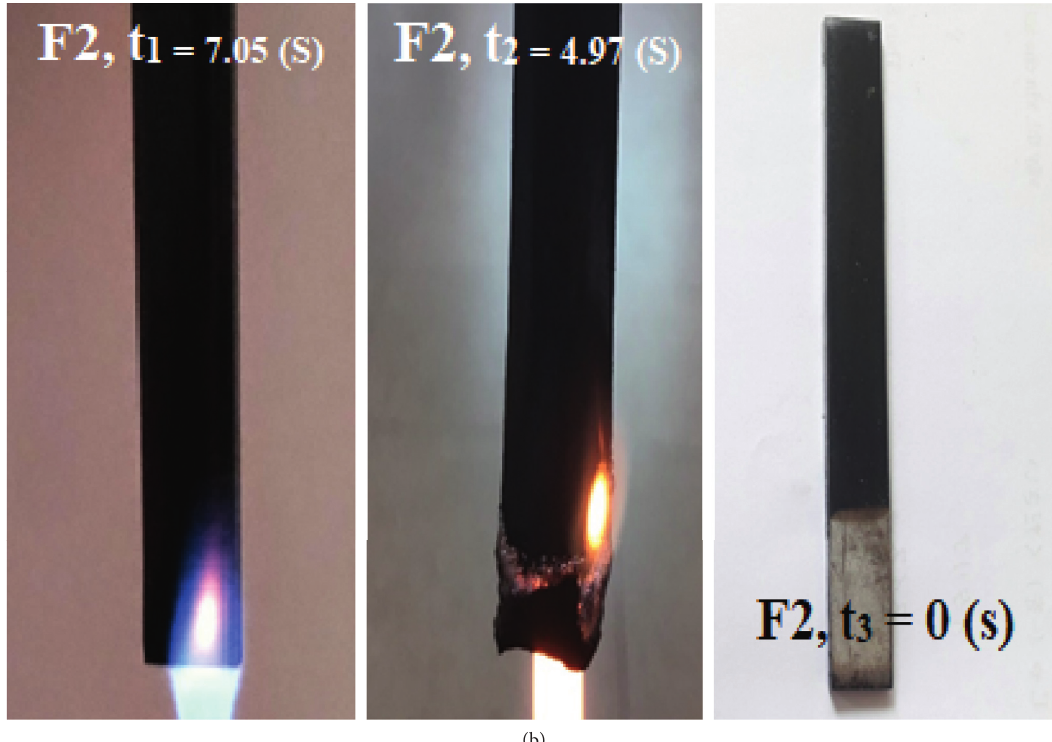
Figure 6: Test image of coating according to UL 94V method and surface of steel after burning. (a) F3(1.5 wt.% MWCNTs, 10 wt.% FA). (b) F2 (1 wt.% MWCNTs, 10 wt.%